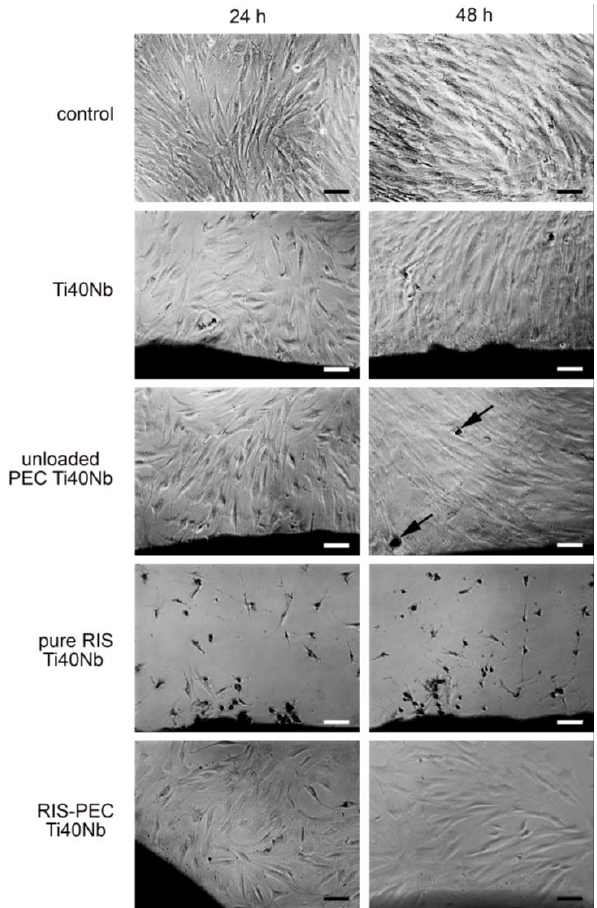
Figure 16. Biocompatibility of human mesenchymal stem cells (hMSC) on RIS loaded PEC at Ti40Nb after incubation of 24 and 48 h and its controls monitored by digital photography (scale bars: 100 μm).